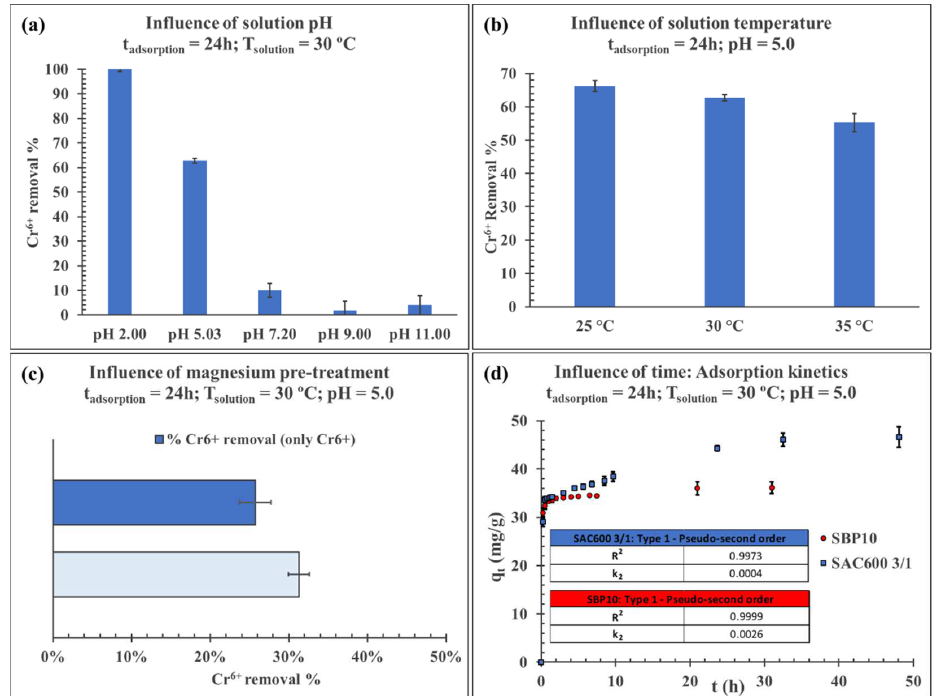
Figure 5. Adsorption experiments: ( a ) Influence of solution pH; ( b ) influence of solution tempera- ture; ( c ) influence of solution ionic strength with magnesium chloride; ( d ) influence of contact time (adsorption kinetics).